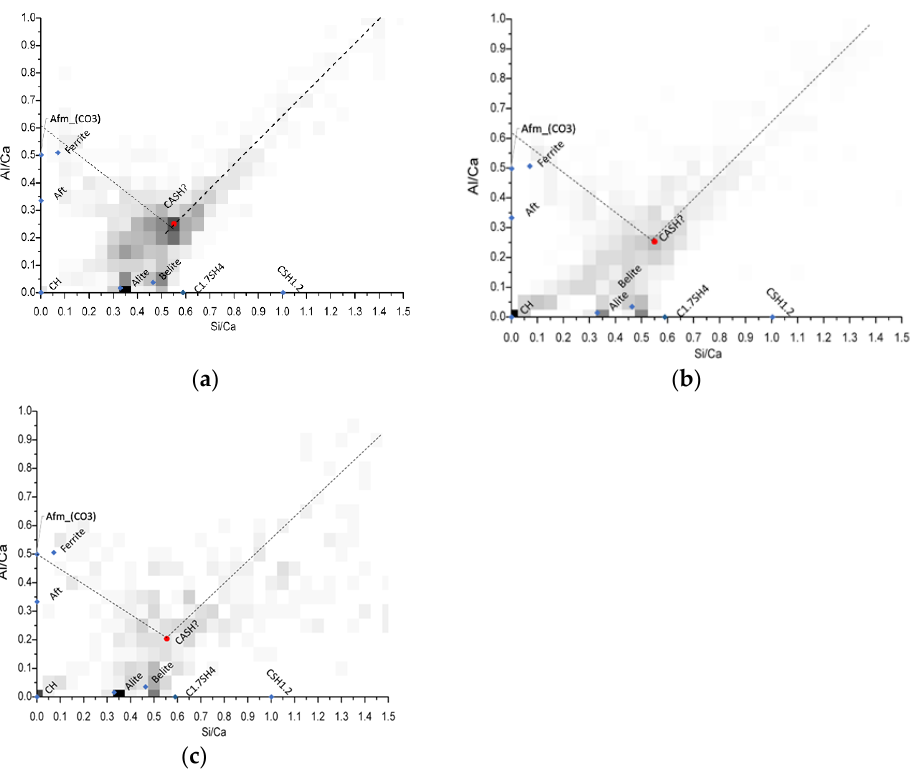
Figure 10. Bivariate Histograms for the definition of C-A-S-H composition for mixtures M15 ( a ) M15L ( b ) and M15Q ( c ) after 91 days of standard curing. Table 5. C-A-S-H composition for mixtures M15, M15L and M15Q after 91 days of standard curing.